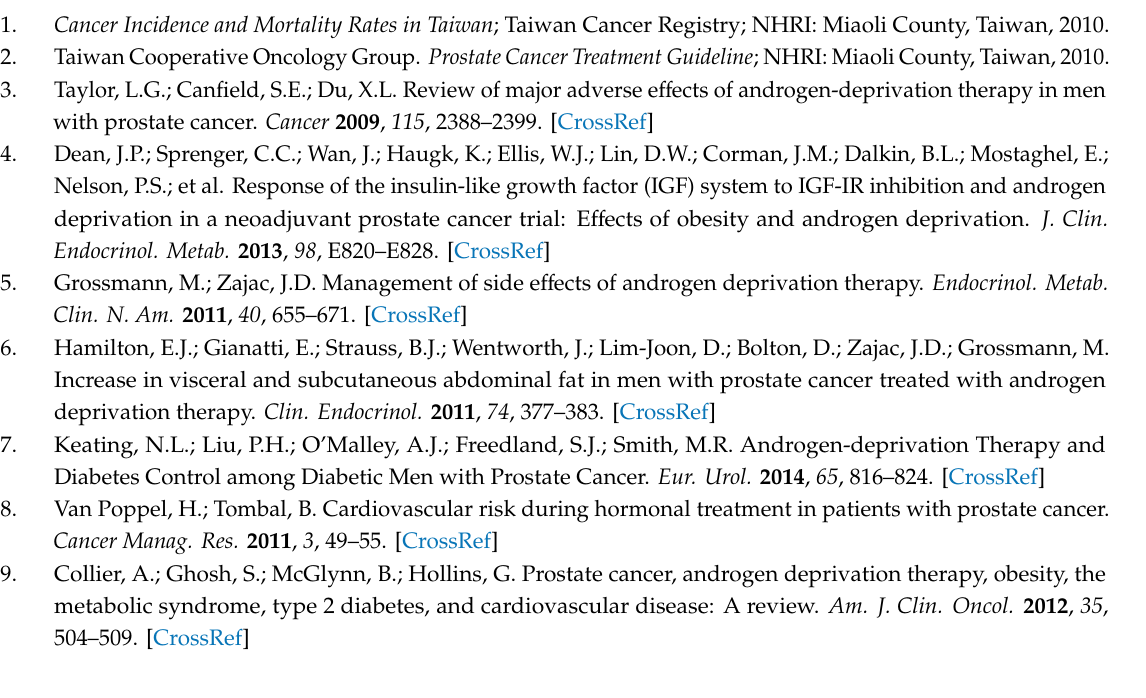
Table S1: Distribution of baseline patient characteristics according to the status of androgen deprivation therapy (ADT) within the first year of cancer diagnosis by age group. Figure S1: Q-Q plot for age at